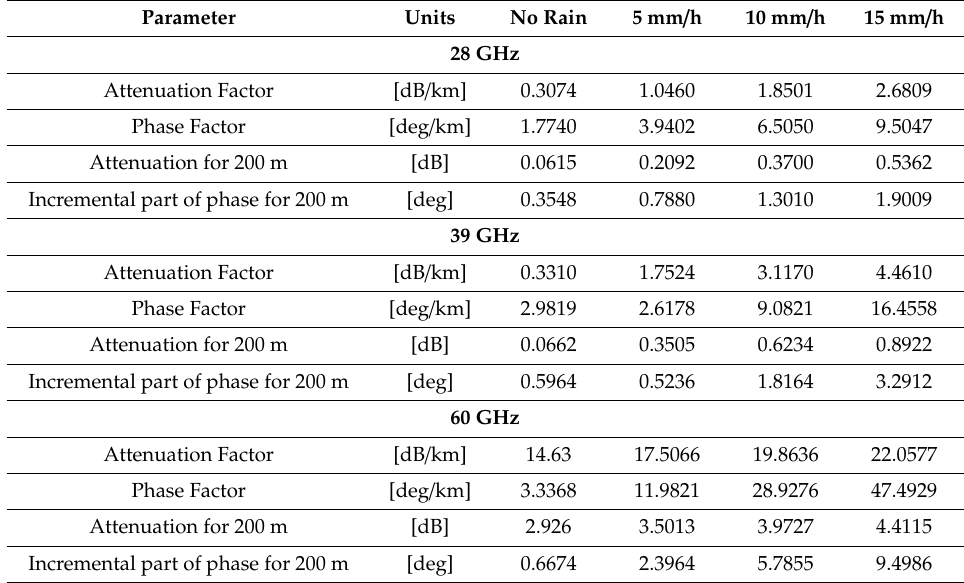
Table 4. Propagation factors of 28, 39, and 60 GHz for 200 m wireless link.